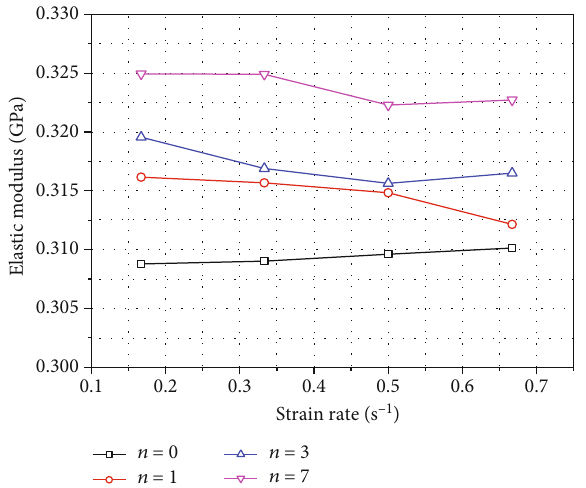
Figure 6: Strain-rate-dependent curve of elastic modulus at di ff erent bend